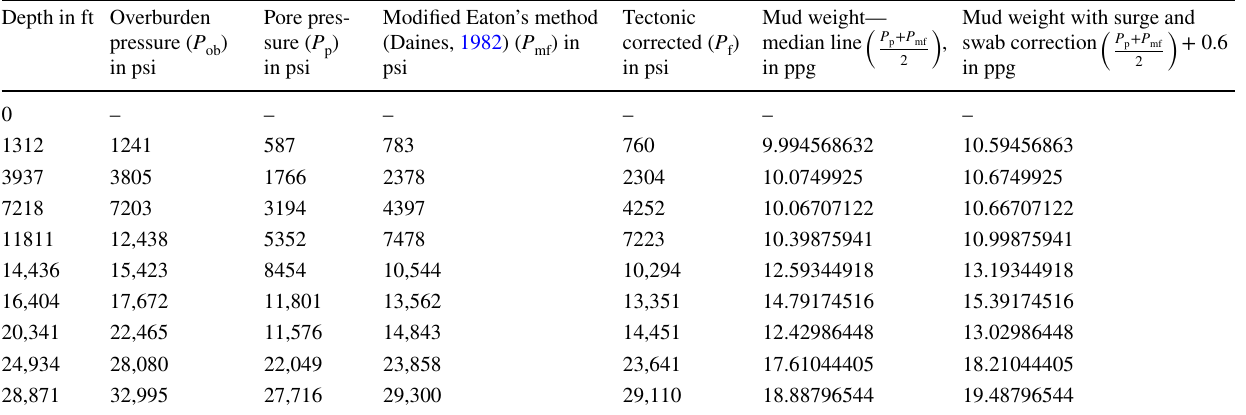
Table 3 Selected mud weight on the top of Atharamura anticline—median line principle Depth in ft Overburden pressure ( P ob )